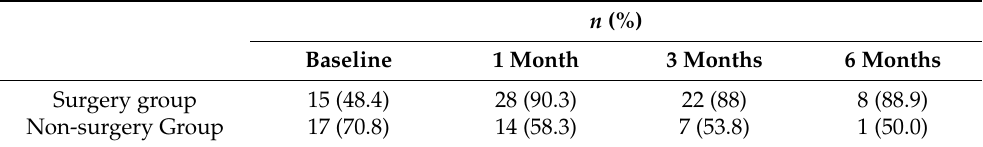
The values represent the number of ambulatory patients as a percentage of the number of live patients at each timepoint.